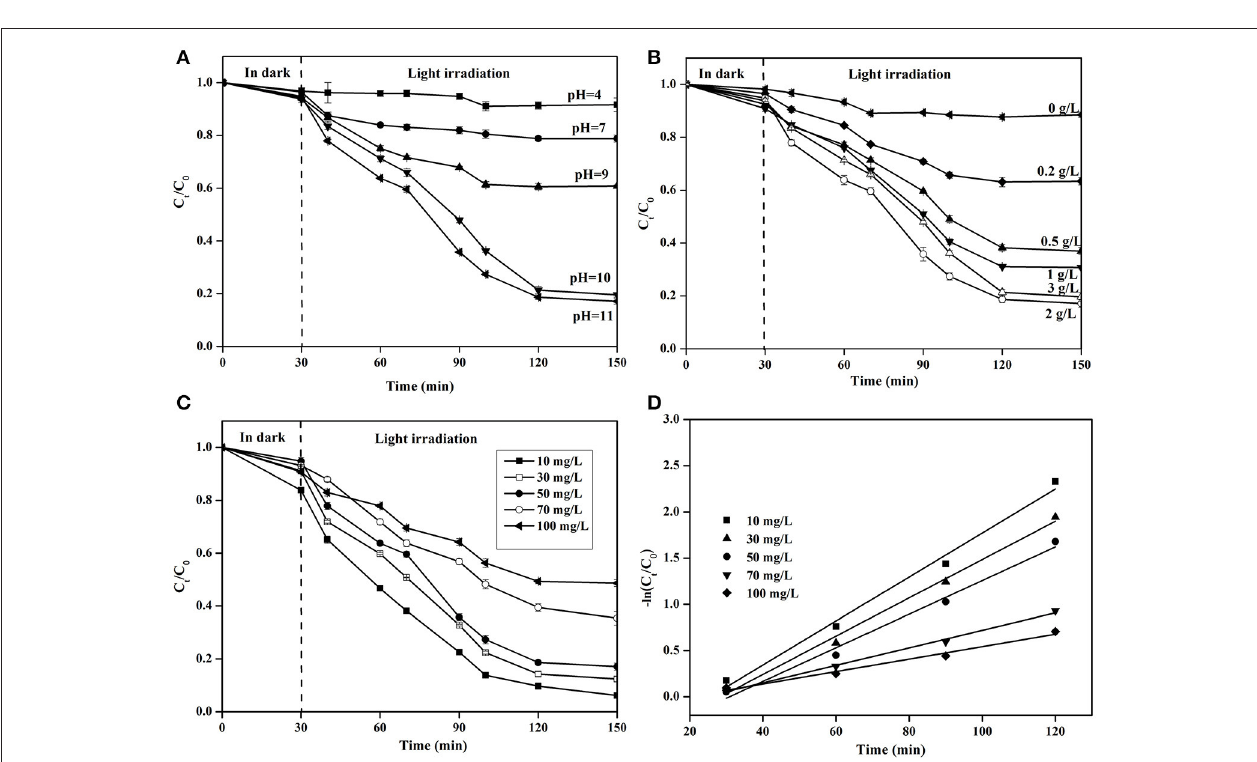
FIGURE 7 | Photocatalytic NH + 4 -N removal efficiency (A) at different pH, (B) at various Cu/ZnO/rGO dosages, and (C) at various NH + 4 -N concentrations, (D) overall photocatalysis reaction kinetics.